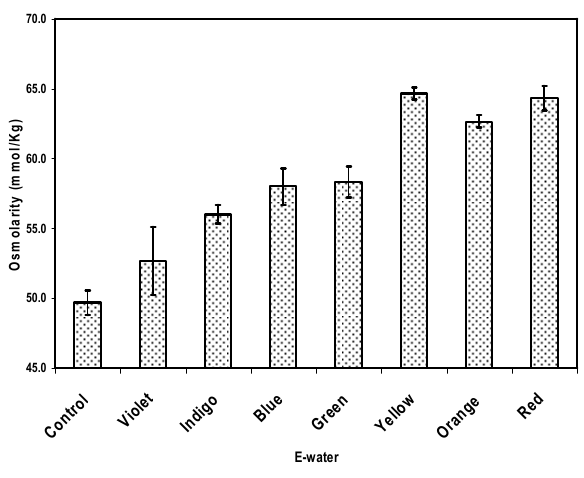
Figure 5A: Osmolarity study of different E-waters by Osmometer. Measurements were taken in triplicate and are represented as Mean ± SD. E-Red waters exhibited higher osmolarity when compared with E-control. The binomial equation for the distribution of osmolarity which gives the best fit is: y = 0.0054x 2 - 0.7335x + 26.931, with an R 2 = 0.9325, where y = photon energy in electron volts (eV), and x is the osmolarity (mmol/Kg) (Figure 5B).